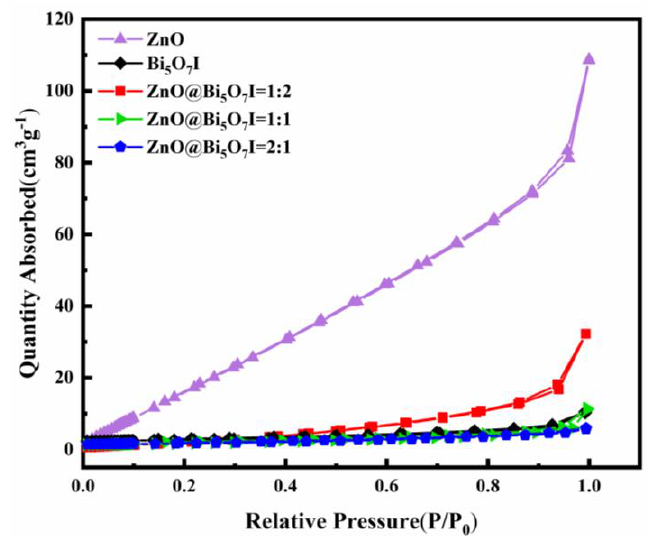
Table 1. Specific surface, pore characteristics, and crystallite sizes of the samples.